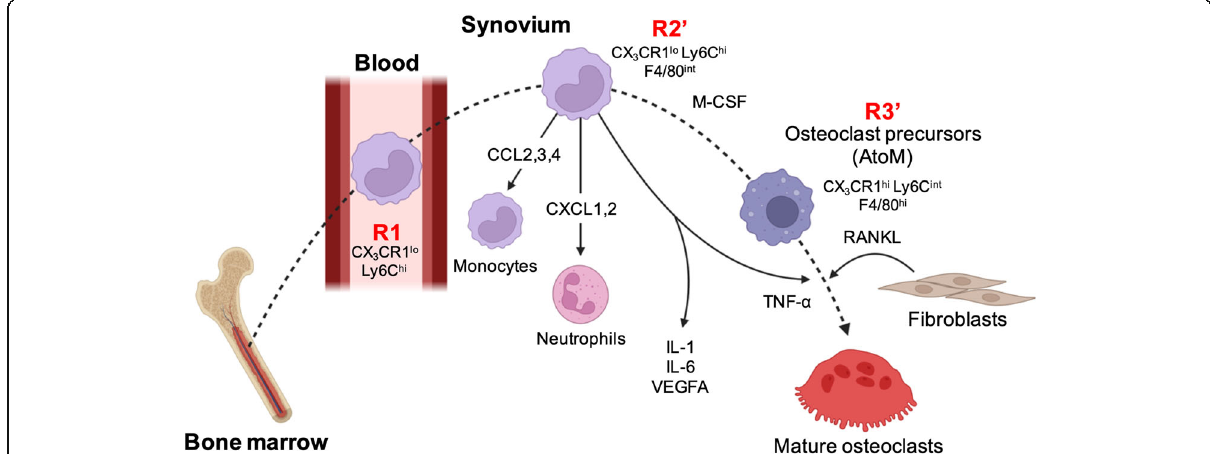
Fig. 4 Newly identified osteoclast precursors in inflamed synovium differentiate into pathological osteoclasts. Schematic of the differentiation pathway of pathological osteoclasts and AtoMs in